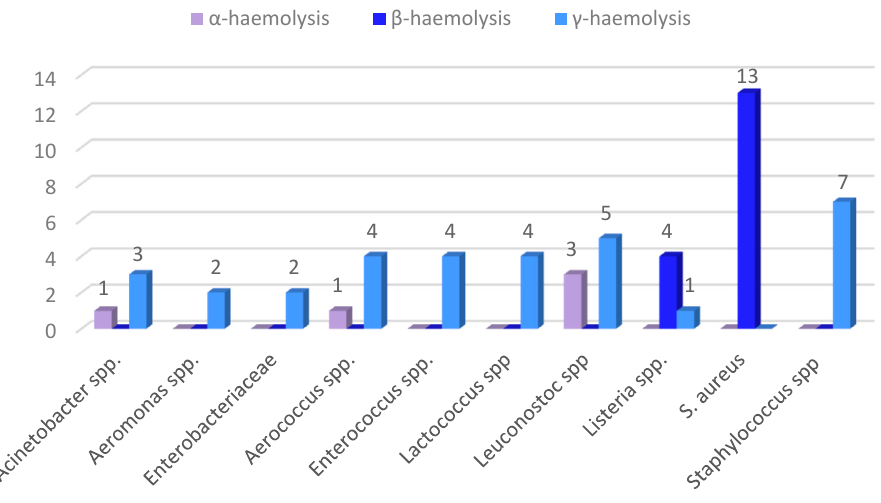
Figure 2. ( a , b ) Haemolysis and gelatinase test results for all tested strains.